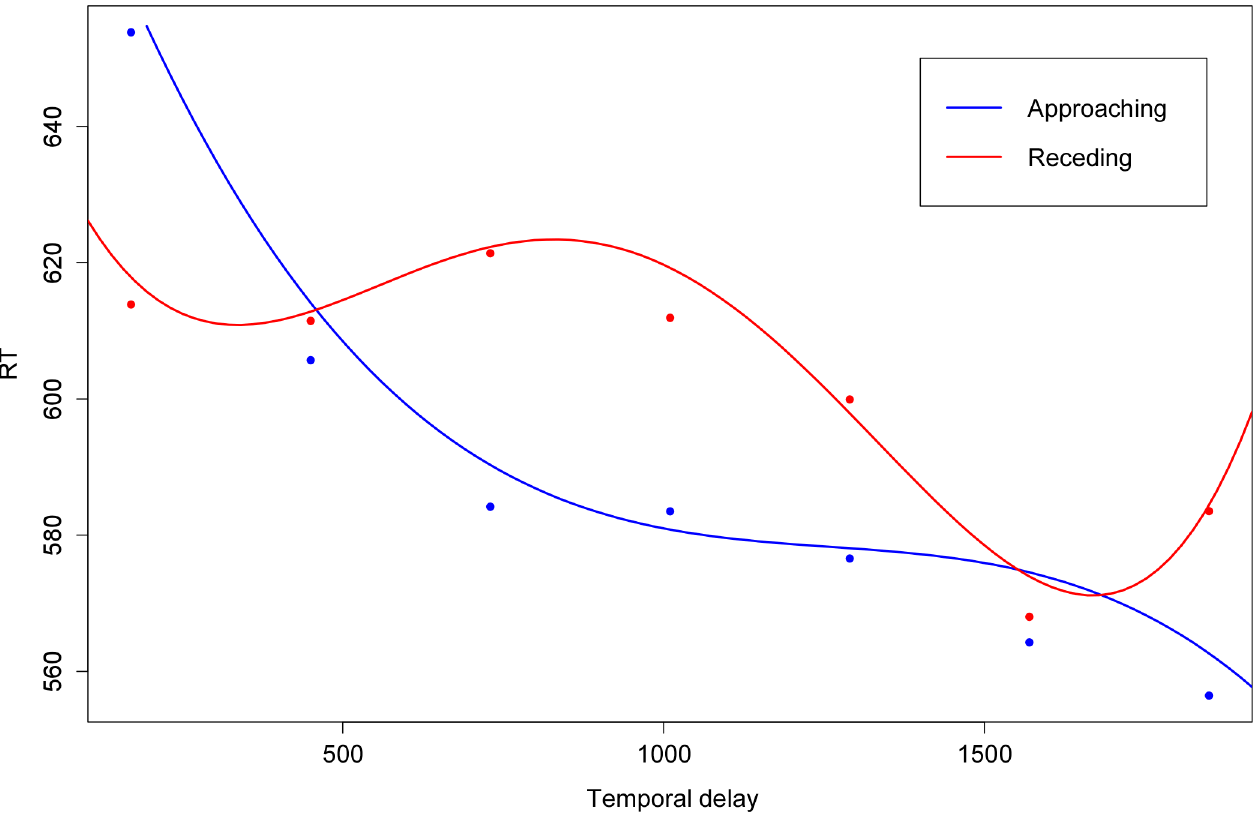
Fig 3. Mean RTs and fitted curves for the relationship between temporal delay and reaction time (RT) for congruent trials. For approaching visual stimuli a cubic model fitted the data best. For receding visual stimuli, a quartic model was used to describe the data.